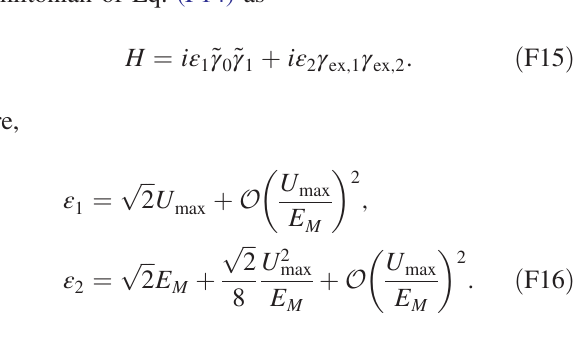
FIG. 16. Low-energy MZM